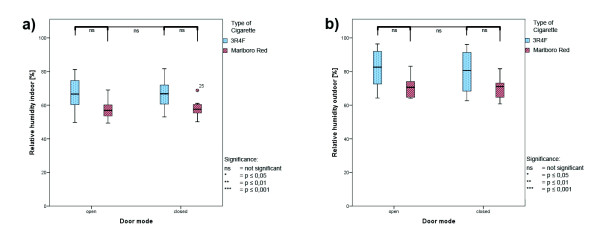
Climate parameters during ETS measurement – relative humidity. a) indoor relative humidity; b) outdoor relative humidity; red: Marlboro Red; blue: 3R4F reference cigarettes; values are averages for the total time interval.